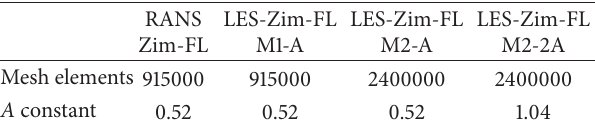
Table 2: Performed